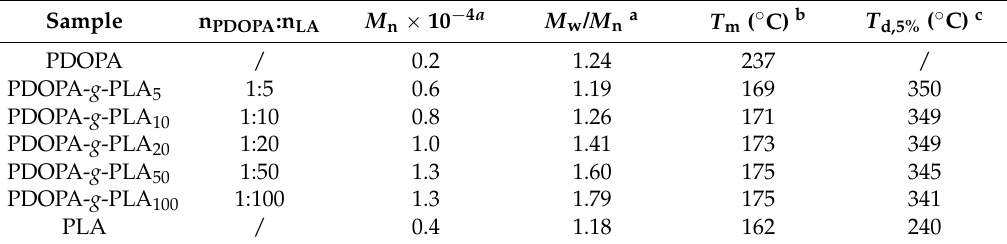
Table 1. Synthesis and characterization of the PDOPA- g -PLA